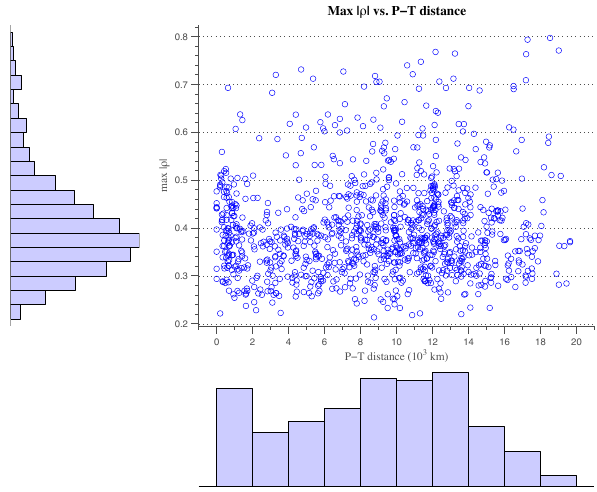
Fig. 2. Maximum absolute correlation coefficient | ρ | between prox- ies of the M08 network and the HadCRUT3v grid point tempera- tures vs. the corresponding distance between the proxy location and the grid point. On the y axis is the histogram of the maximum | ρ | ; on the x axis is the histogram of distance between each proxy P i and the corresponding temperature grid T j that gives the highest | ρ |